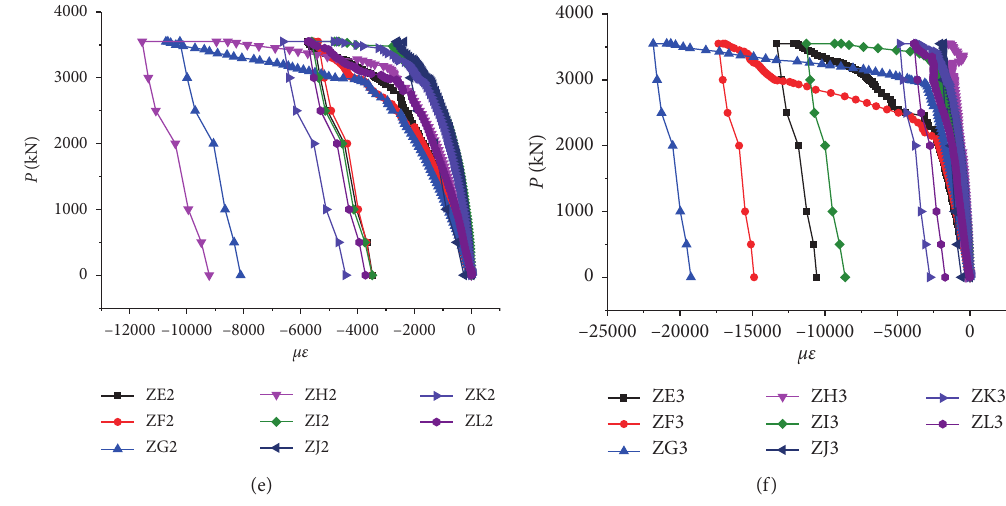
Figure 4: Load-strain curves of longitudinal bars.